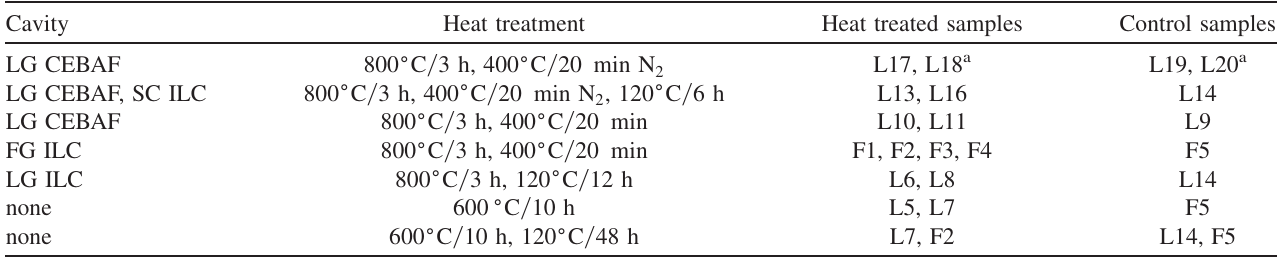
TABLE IV. Heat treatment parameters of large-grain (‘‘L’’ series) and fine-grain (‘‘F’’ series) Nb samples with the single-cell